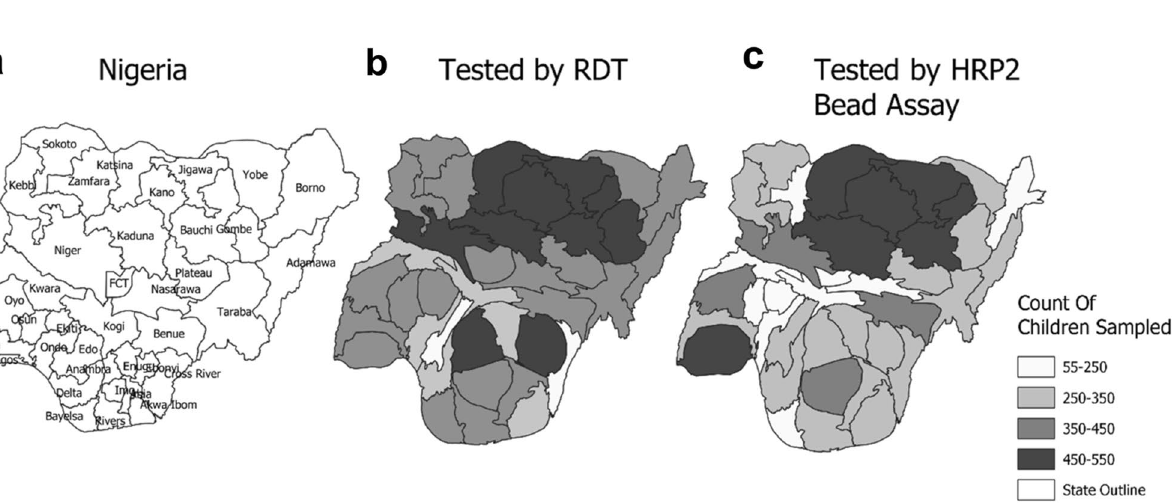
Figure 1. Test results as available for Nigerian states and FCT. Geopolitical state boundaries of Nigeria ( a ) and cartograms illustrating unweighted counts of children with test results for RDT from the DHS ( b ) and HRP2 bead assay from NAIIS samples ( c ). Maps were generated using QGIS version 3.12.2 (www. qgis.